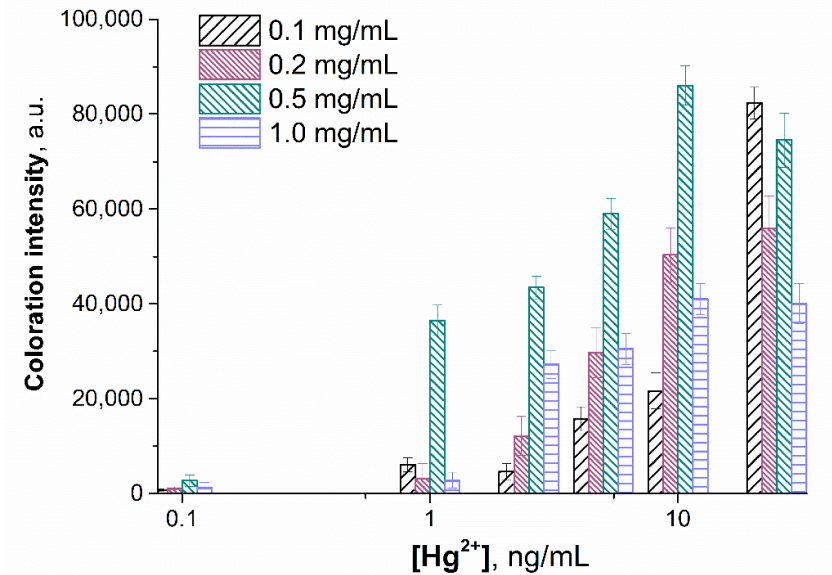
Figure 6. Effect of BSA–MSA concentration on Hg 2+ detection by lateral flow test. Error bars show the standard deviation from three replicate